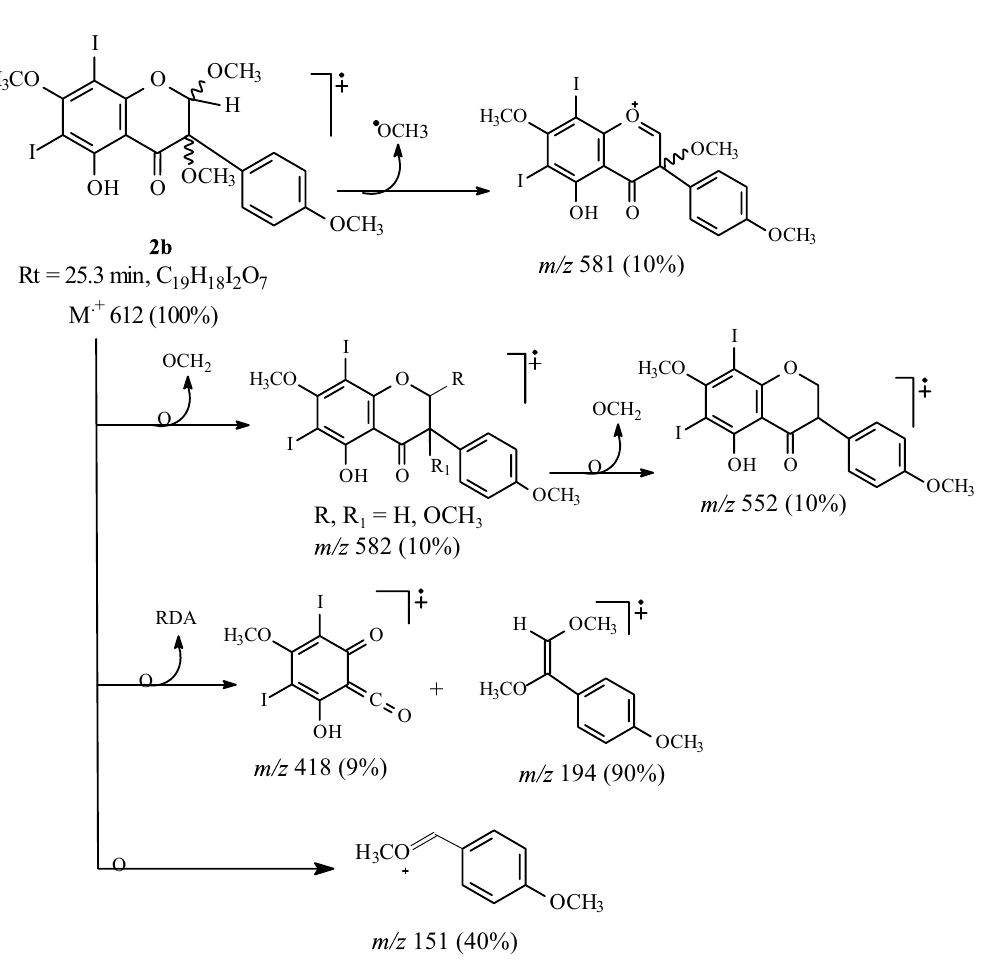
Fig. 5 – Proposed fragmentation patterns for 2b (only peaks classified as